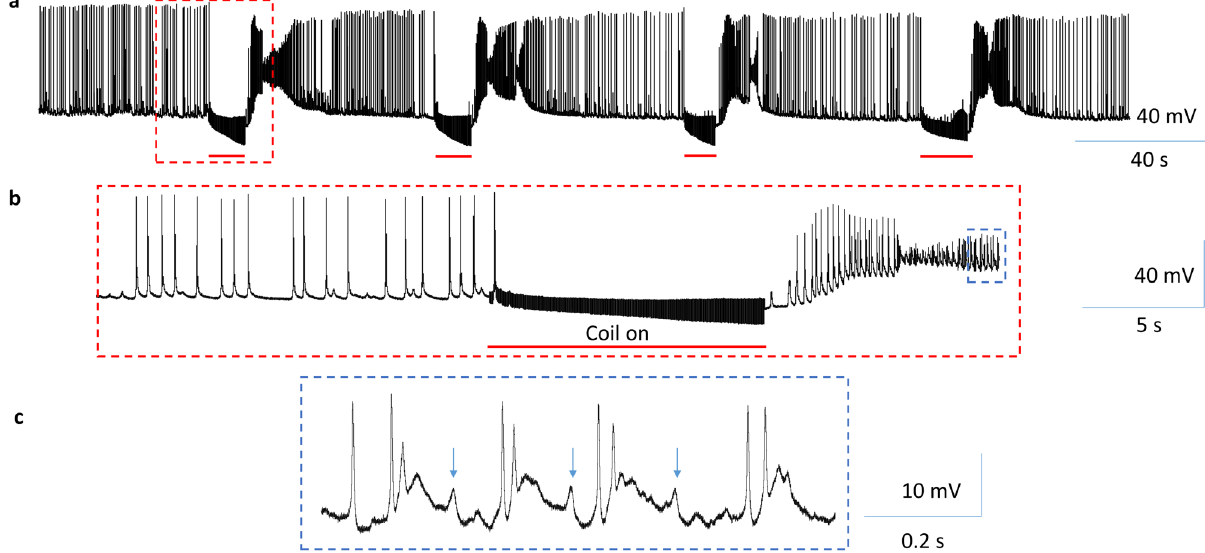
Figure 5. High-frequency magnetic stimulation inhibited somatic neuron activity in a high K + solution. Positon of the miniature coil was as in Fig. 3a. ( a ) Hyperactivity in the B3 neuron was elicited by high K + Aplysia saline. 400 Hz stimulation by the miniature coil rapidly and reversibly eliminated the neuron activity. ( b ) Expended trace in ( a ). ( c ) Expanded trace in ( b ), showing increased excitatory events (arrows) after coil